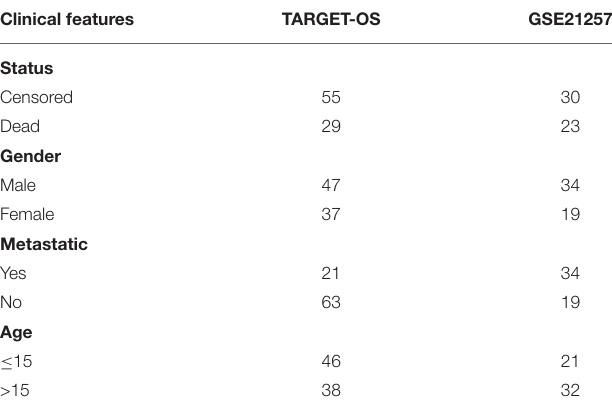
TABLE 1 | Sample clinical